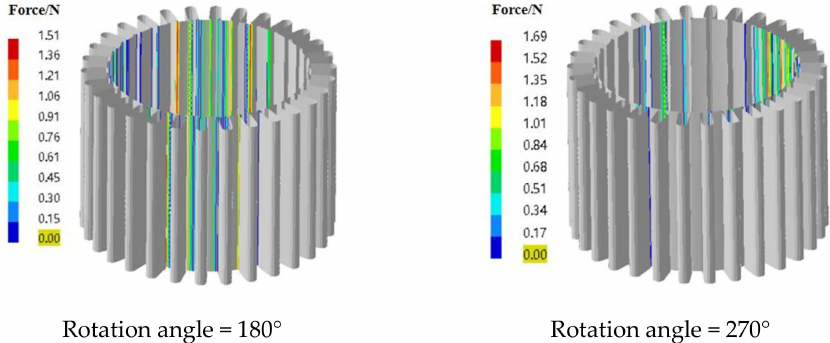
Figure 14. The distribution nephogram of electromagnetic force on the surface of the stator slot at different rotation angles.